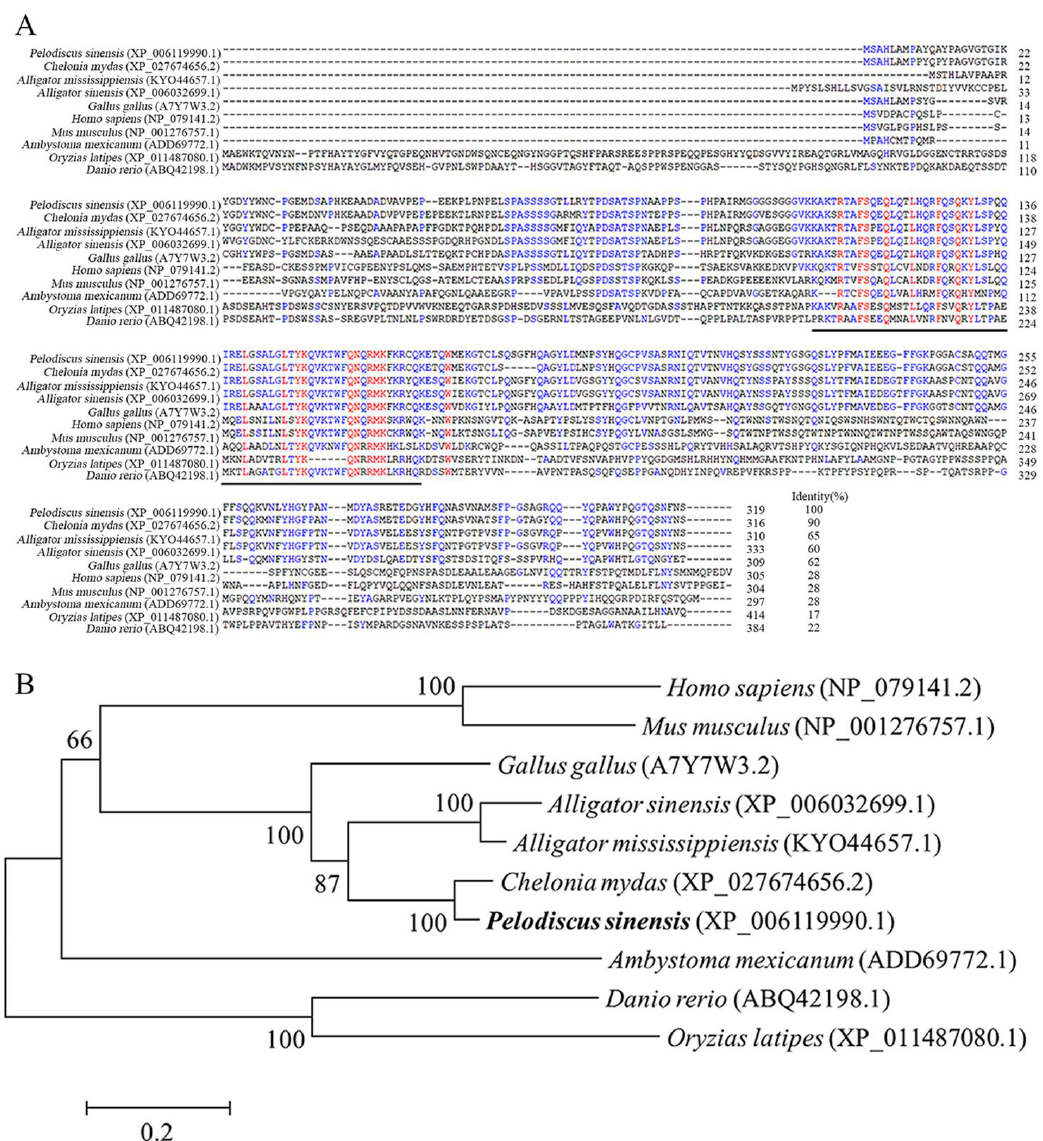
Figure 1. Multiple alignment and phylogenetic analysis of Nanog proteins. ( A ) Multiple alignment of Nanog in different phyla. The conserved homeodomain of 60 amino acids is underlined with a thick line. The identical amino acids are shown in red letters. The species names and GenBank accession numbers are shown to the left, and Identity scores relative to Chinese soft-shell turtle are shown on the end of the alignment. The alignment was generated with Vector NTI 11. ( B ) Phylogenetic analysis of Nanog in different species. The phylogeny tree was constructed by Mega 6.0 using the Neighbor-joining method. The bootstrap value was set to 1000.